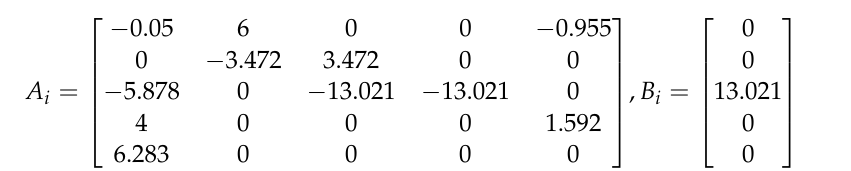
Figure 5. Physical connection of the multi − area power system.